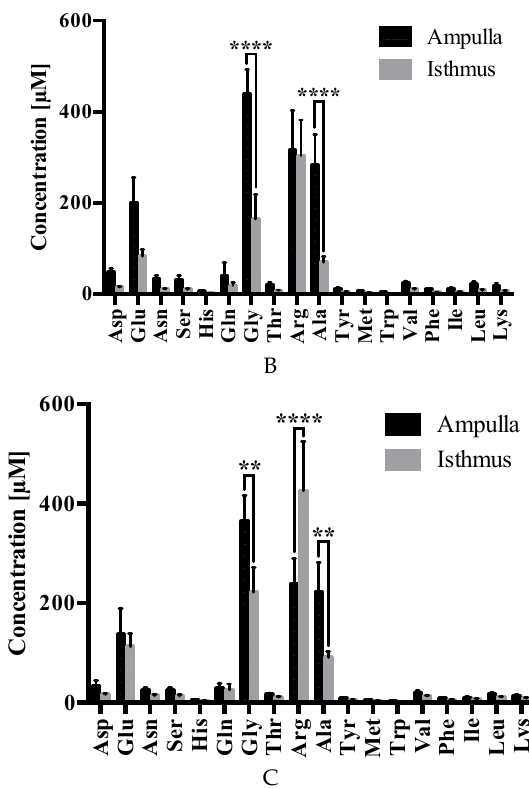
Figure 5. Amino acid concentrations ( ± SEM) in the ( A ) isthmus of cyclic vs. pregnant heifers, in addition to ampullary vs. isthmic comparisons from ( B ) cyclic and ( C ) pregnant heifers–wherein **** p ≤ 0.0001; ** p ≤ 0.01 and * p ≤ 0.05. Abbreviations: Aspartate (Asp), Glutamate (Glu), Asparagine (Asn), Serine (Ser), Histidine (His), Glutamine (Gln), Glycine (Gly), Threonine (Thr), Arginine (Arg), Alanine (Ala), Tyrosine (Tyr), Methionine (Met), Tryptophan (Trp), Valine (Val), Phenylalanine (Phe), Isoleucine (Ile), Leucine (Leu), and Lysine (Lys).